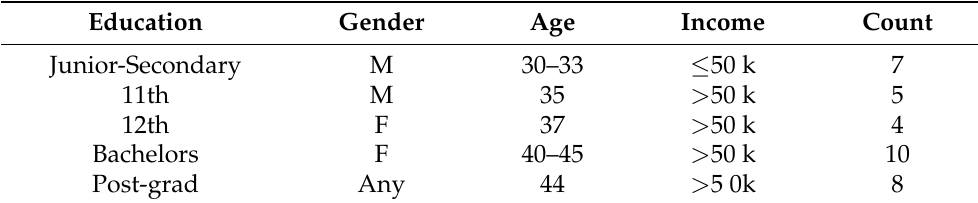
Table 4. Fully anonymized dataset applied to the original